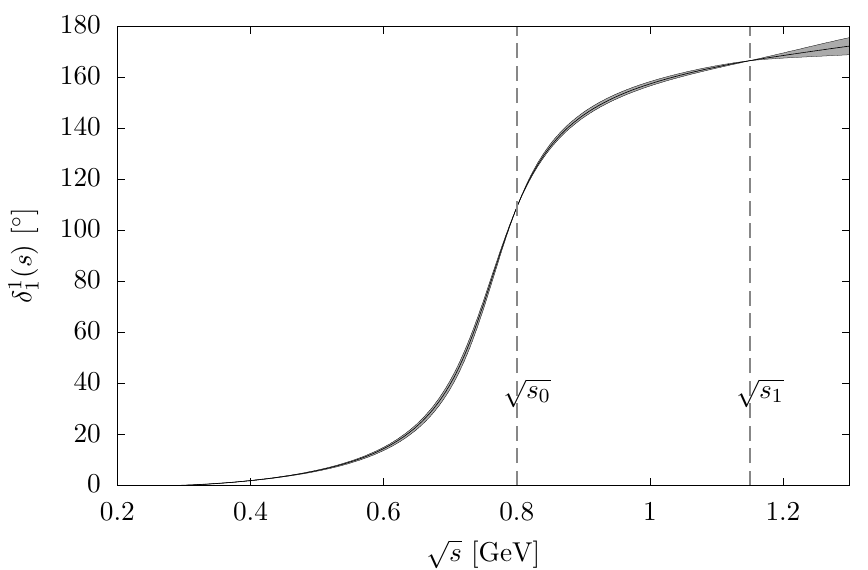
from the solution of the Roy equations [10]. 1